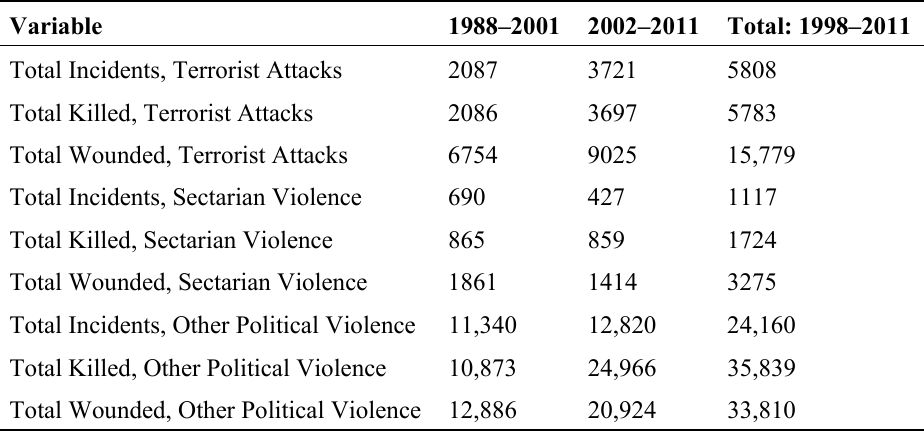
Table 1. BFRS political violence.